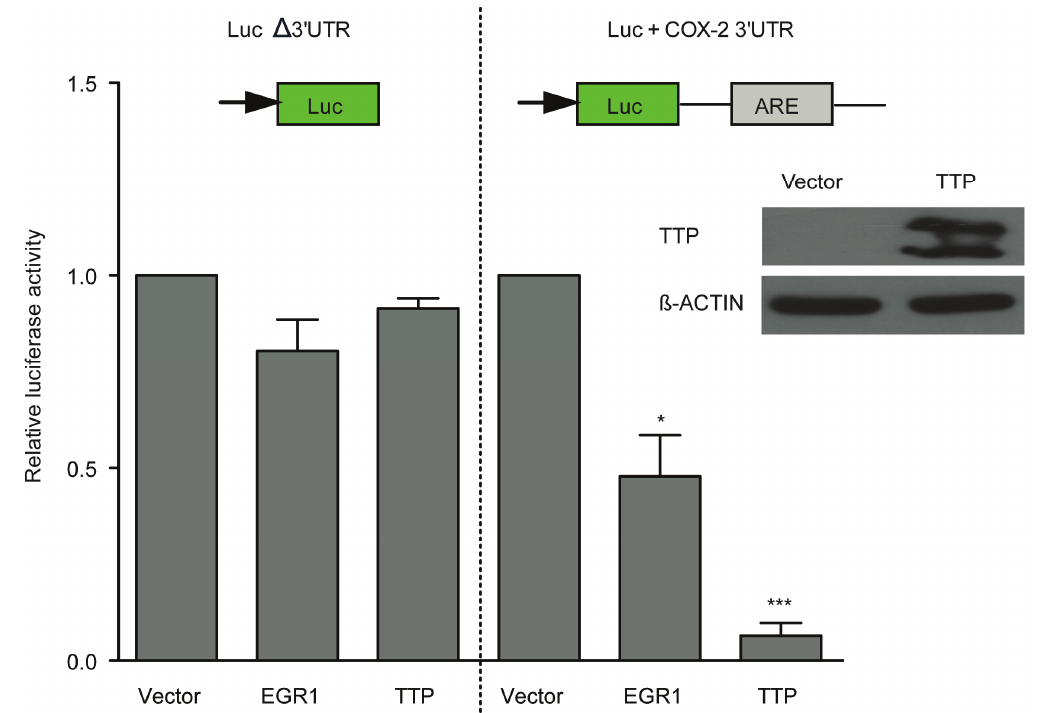
Figure 10. EGR1 expression downregulates COX-2 in an ARE-dependent manner. HCT116 cells were transfected with pcDNA3.1/Zeo/EGR1-Flag or vector control, along with luciferase reporters with (Luc+COX-2 3' UTR) or without (Luc(cid:6)3' UTR) the 3' UTR region of COX-2. Twenty-four hours post-transfection, luciferase activity was assayed and normalized to total protein concentration. As a positive control, transfection of a TTP expression construct was performed; inset shows TTP protein expression in transfected cells by Western